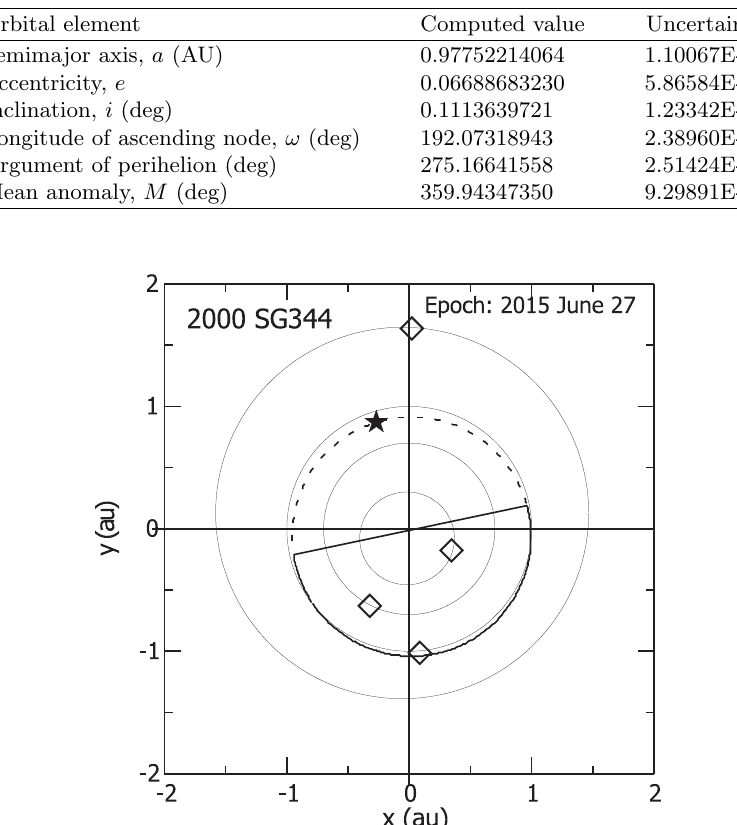
Fig. 1. The orbit of 2000 SG344 in the ecliptic plane. The positions of the asteroid and planets are shown for the epoch 2015 June 27. The dashed line denotes the part of the orbit below the ecliptic